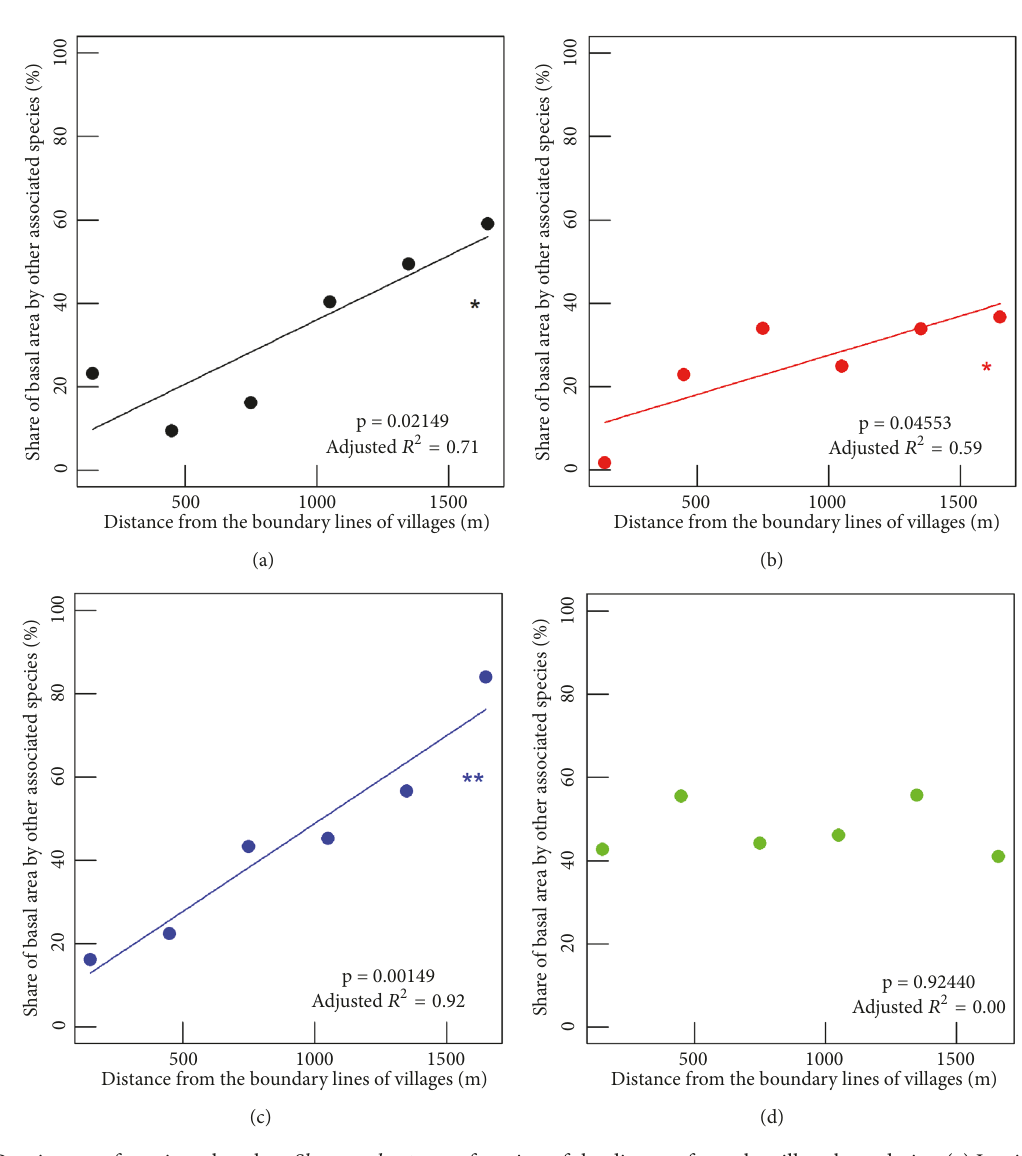
Figure 7: Dominance of species other than Shorea robusta as a function of the distance from the village boundaries. (a) Janajagaran BZCF: significant (p < 0.05), (b) Musharni Mai BZCF: significant (p < 0.05), (c) Radha Krishna BZCF: significant (p < 0.01), and (d) Parsa Wildlife Reserve: nonsignificant (p > 0.05).